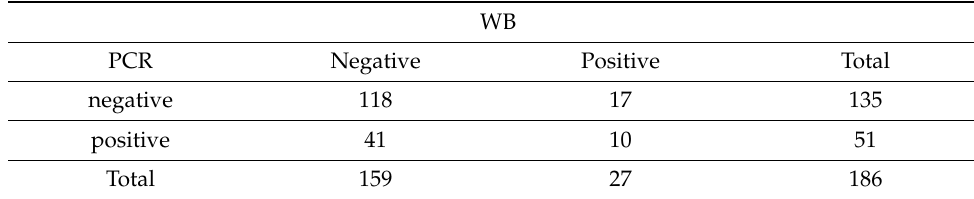
Table 1. Results of polymerase chain reaction (PCR) and WB.